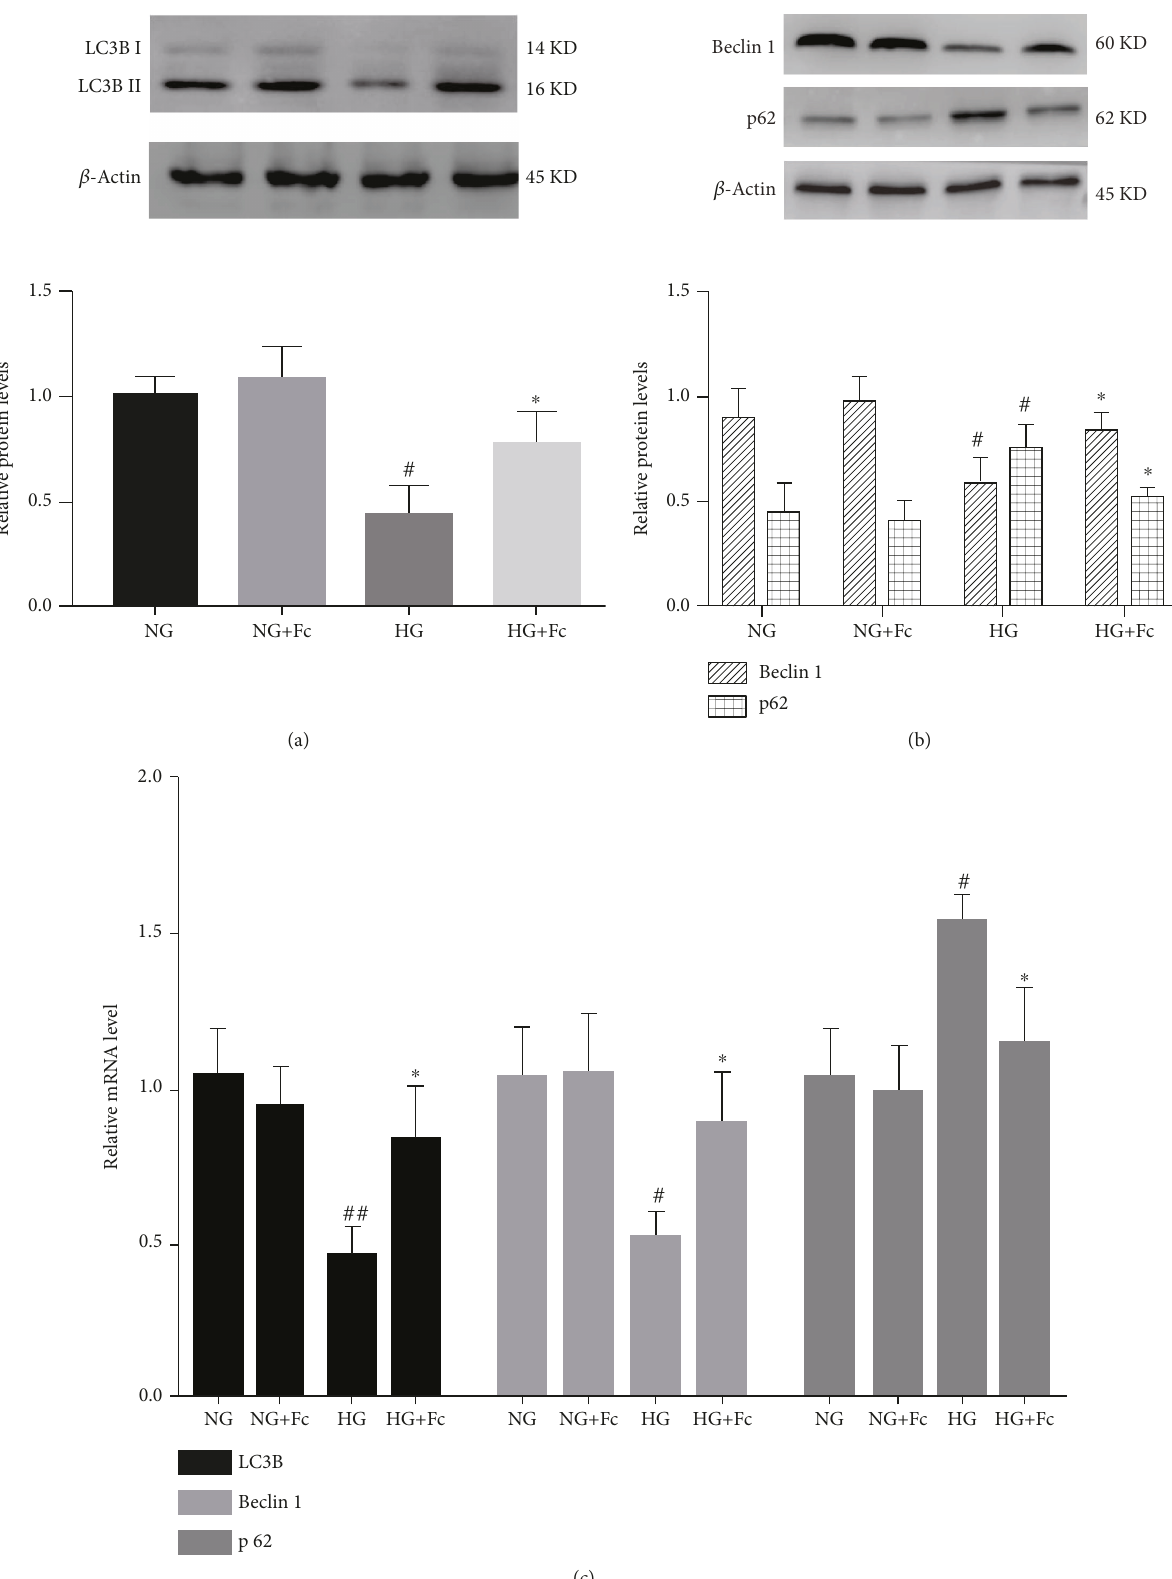
Figure 5: Notoginsenoside Fc (Fc) prevents HG-induced autophagy reduction in rat aortic endothelial cells. (a, b) Expression of LC3B, Beclin 1, and p62 proteins was detected by Western blot analysis. (c) Expression of LC3B, Beclin 1, and p62 mRNA was detected by RT-qPCR. # P < 0 05 and ## P < 0 01 vs. the normal-glucose (NG) group; ∗ P < 0 05 vs. the high-glucose (HG) group. n = 3